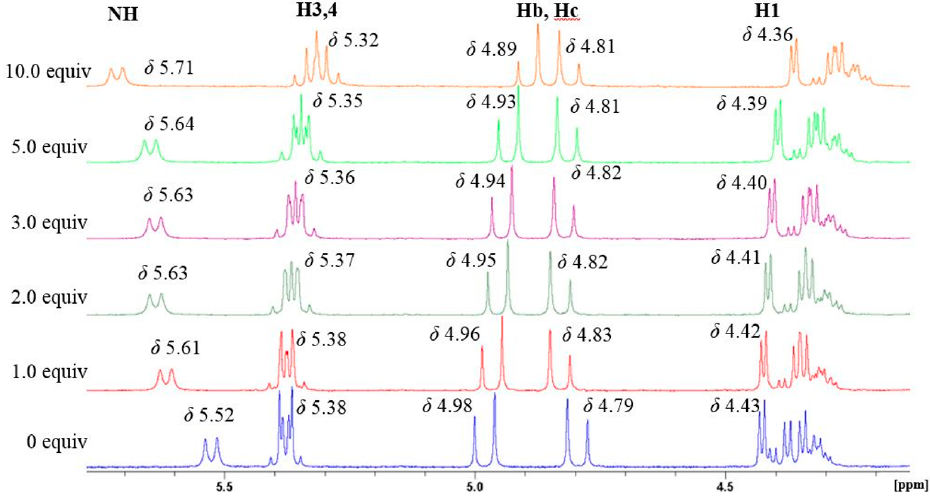
Figure 4. 1 H NMR spectra of C2-monotriazole compound 22 at different concentrations of